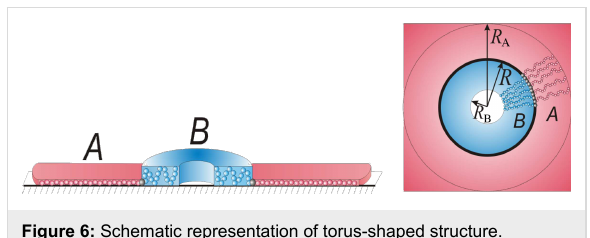
Figure 6: Schematic representation of torus-shaped